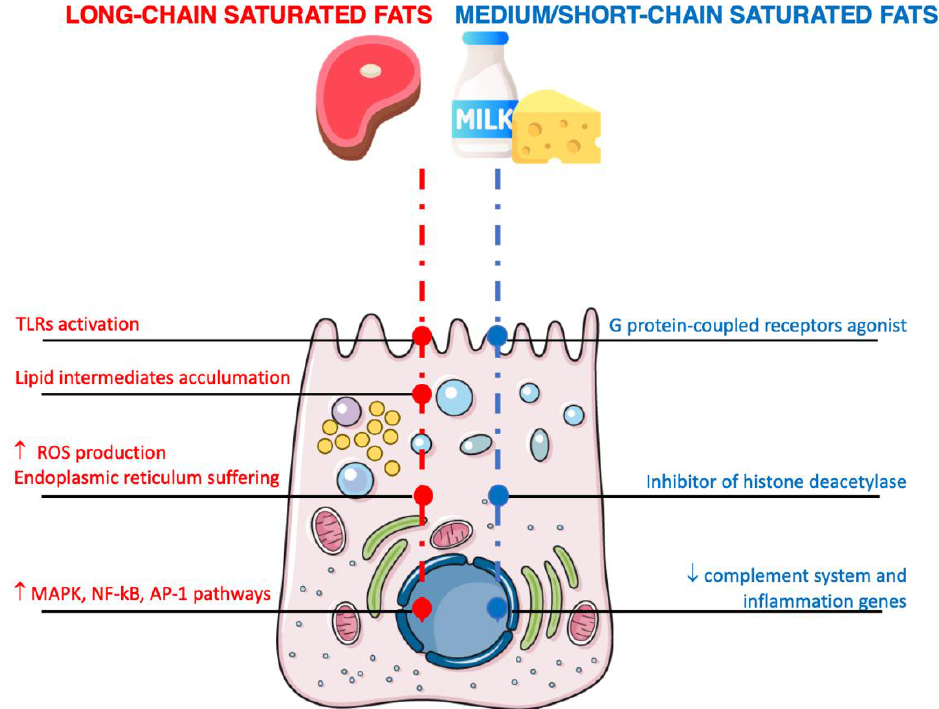
Figure 2. Mechanisms of action related to the effects of the inflammatory pathways of saturated fatty acids on intestinal cells. Arrows denote increment/increase or decrement/decrease.